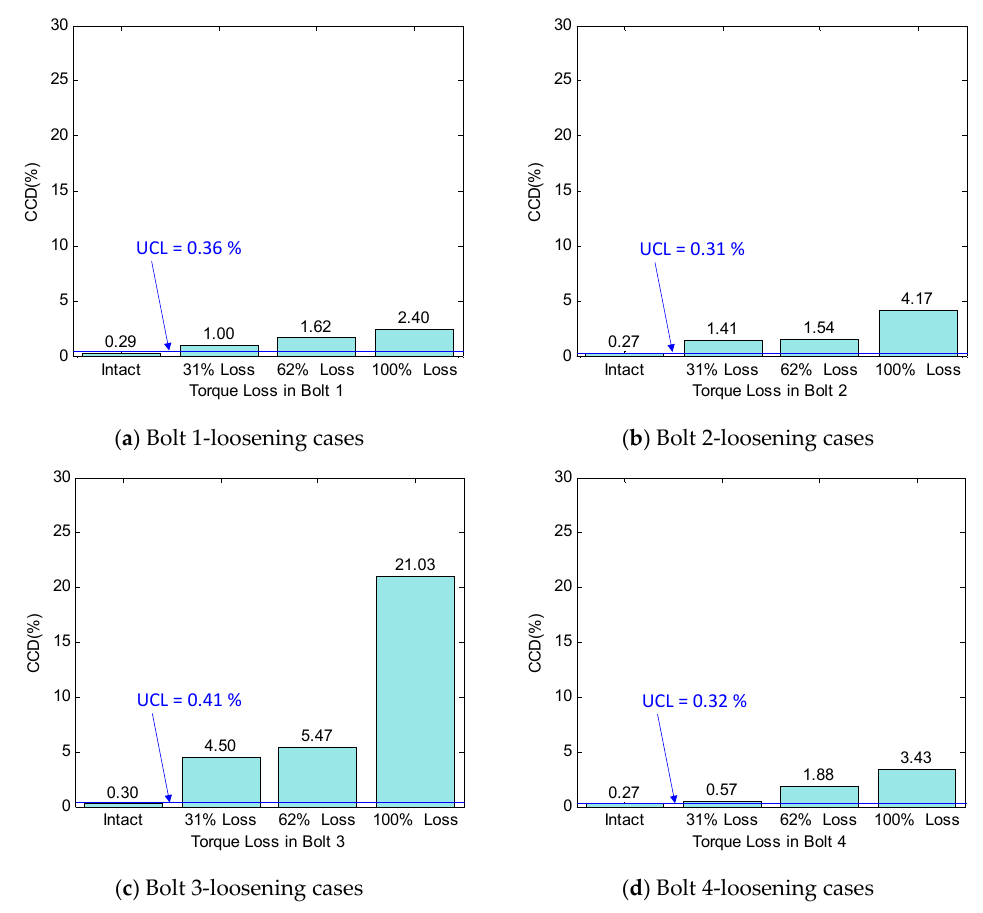
Figure 15. Preload change monitoring of bolted connection by correlation coefficient deviation (CCD) index.